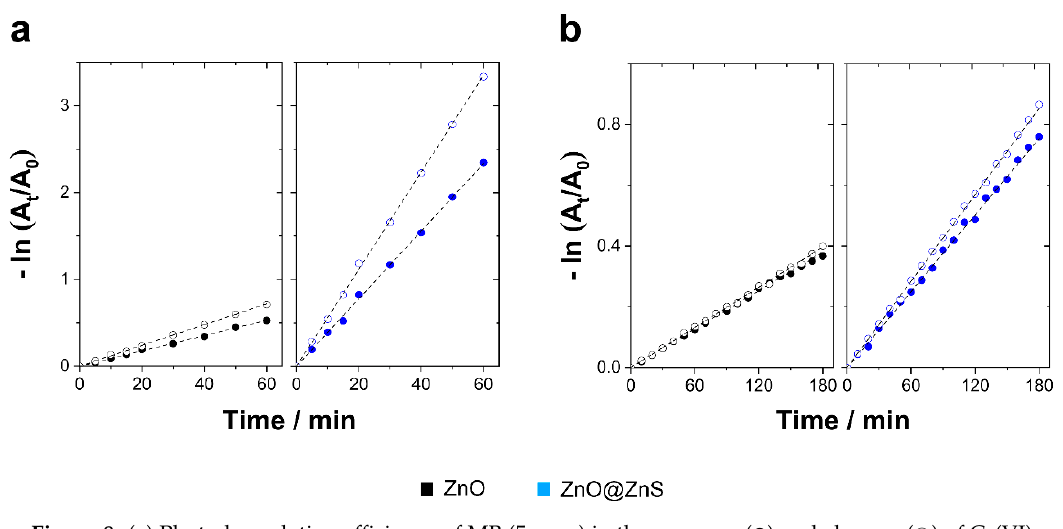
Figure 8. ( a ) Photodegradation e ffi ciency of MB (5 ppm) in the presence ( ● ) and absence ( ○ ) of Cr(VI) ions (20 ppm) under artificial UV-filtered sunlight. ( b ) Photoreduction efficiency of Cr(VI) (20 ppm) in the presence ( ● ) and absence ( ○ ) of MB (5 ppm) under artificial UV-filtered